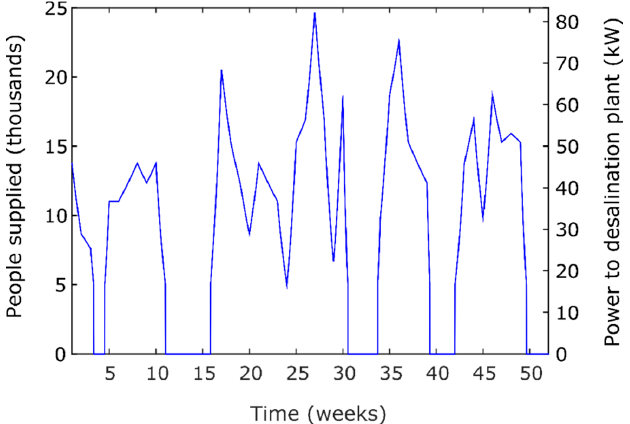
Figure 6. The estimated power output of the MCC and the number of people that each week that could fulfill their basic freshwater demand from a RO plant powered by five MCCs, without water storage, in the WIO.